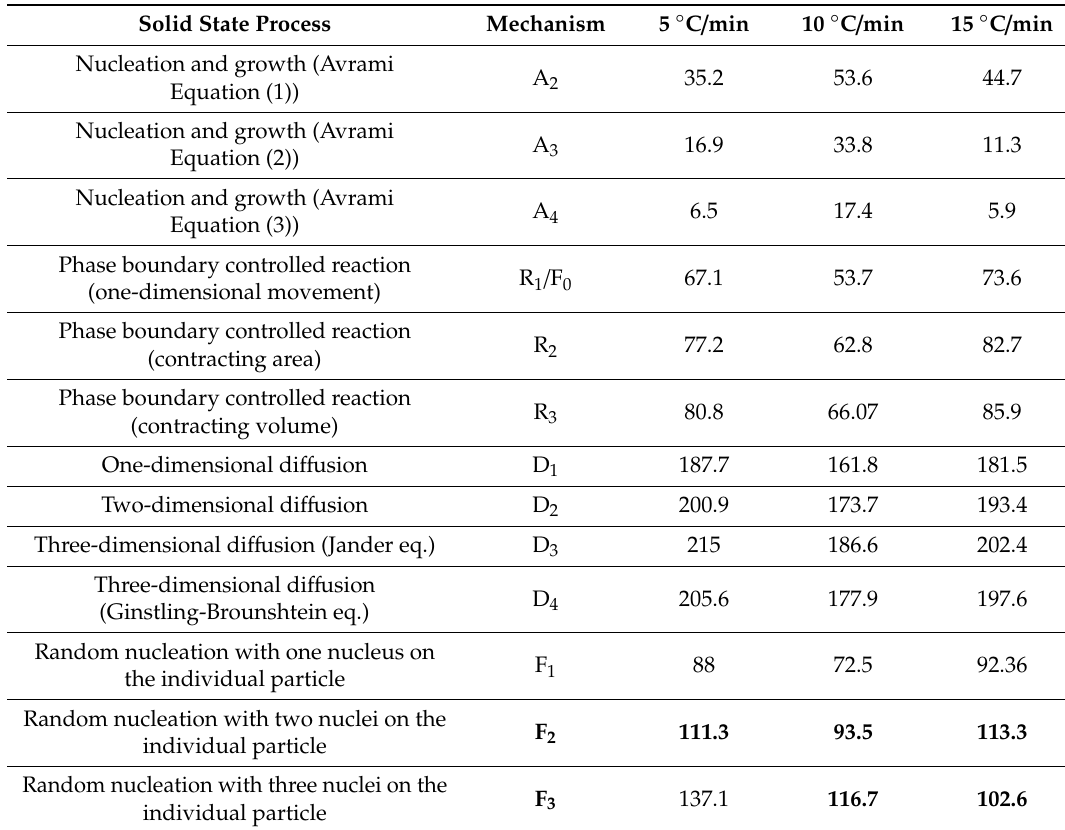
Table 4. Degradation energies at di ff erent heating rates and di ff erent thermodegradation mechanisms for Vespa velutina